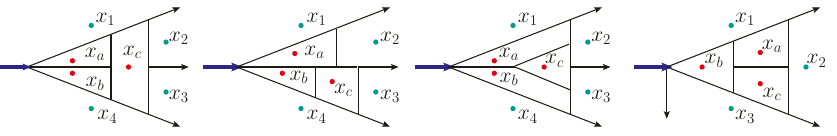
Figure 13. Master graphs for three-loop tr( φ 3 ) form